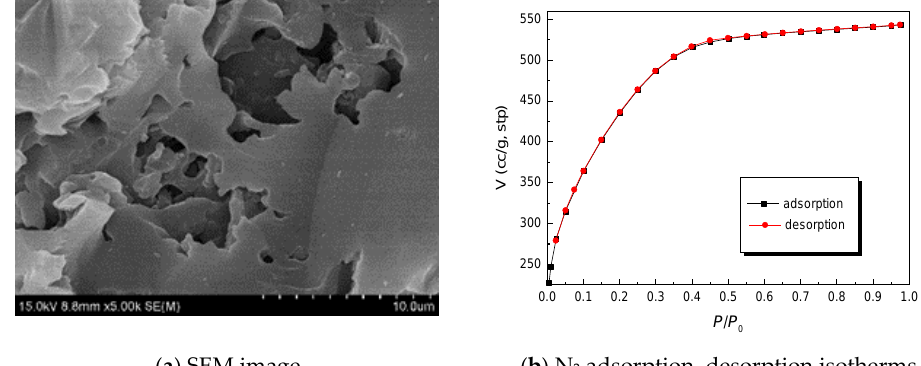
Figure 4. Surface morphology characterization of the CnSAC.